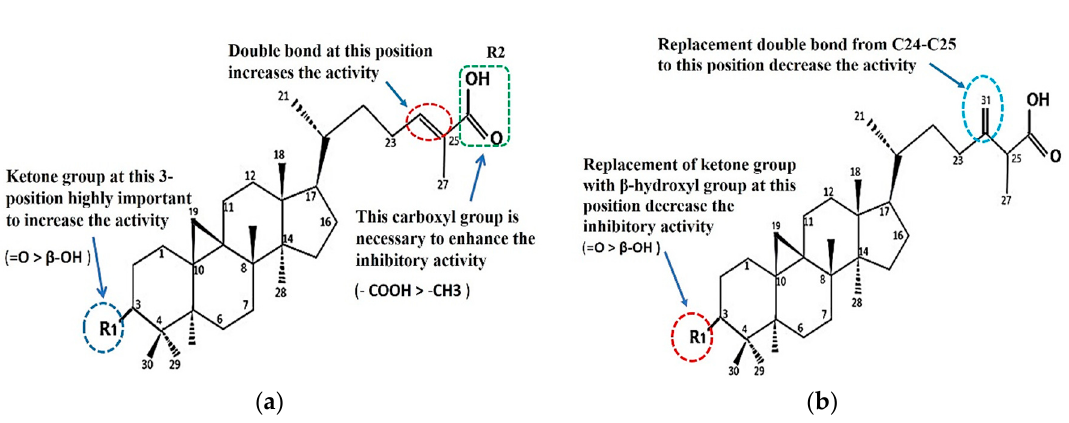
Figure 4. Structure–activity relationship for α -glucosidase inhibition of cycloartane-type triterpenes 1 , 2 , 4 ( a ) and 3 , 5 ( b ) from T. sapiens propolis.